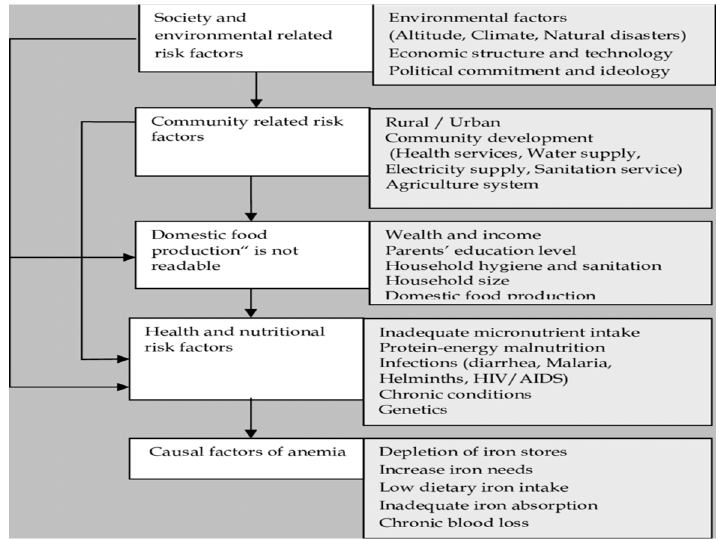
Figure 1. A conceptual framework for the analysis of anemia risk.